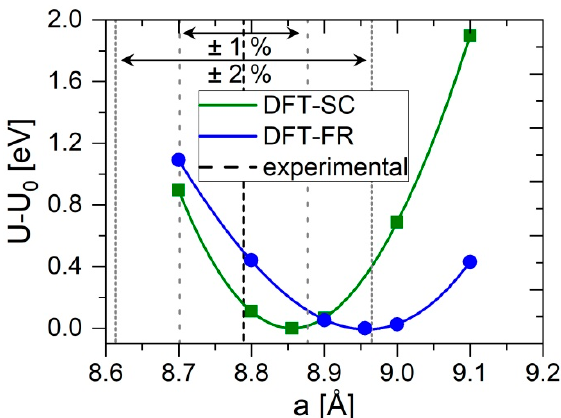
Figure 1. Calculated change in energy U-U 0 as a function of the lattice parameter a of cubic HfV 2 O 7 . Density functional theory calculations were performed with structural relaxation only at equilibrium volume (DFT-SC) and full structural relaxation at each volume (DFT-FR). The dashed line represents the experimentally obtained lattice parameter (480 K) [6]. The grey dashed and dotted lines represent a deviation of 1% and 2% from the experimentally determined lattice parameter, respectively.